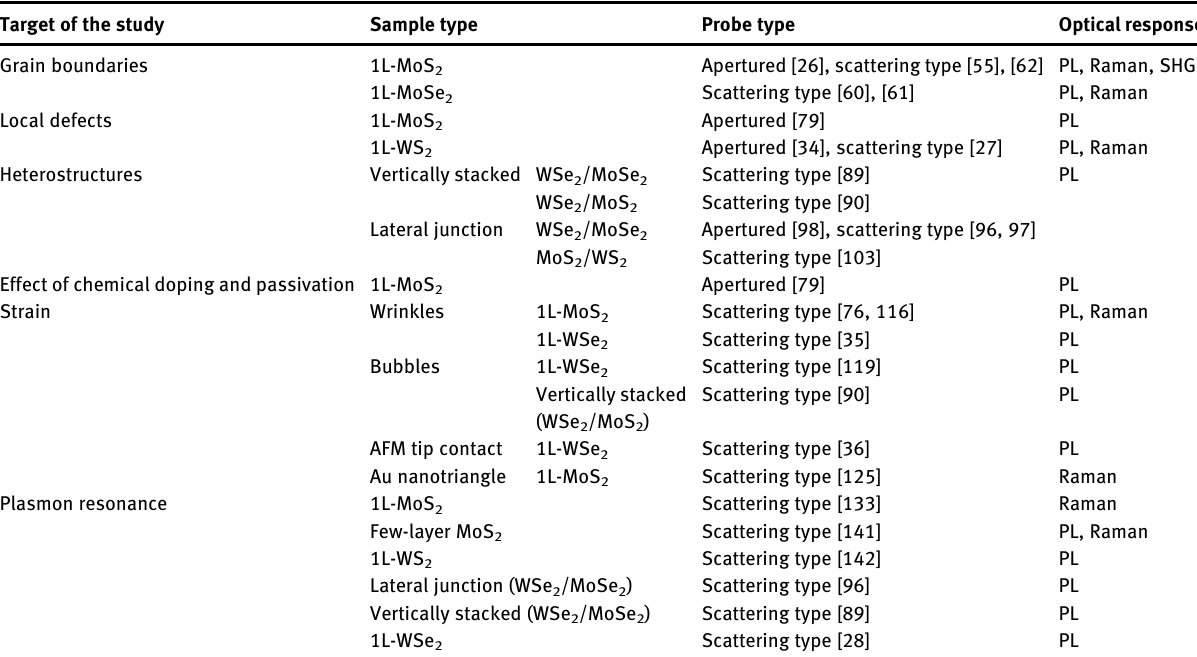
Table  : Summary of experimental details of the near- fi eld optical studies of  D-TMDs. Target of the